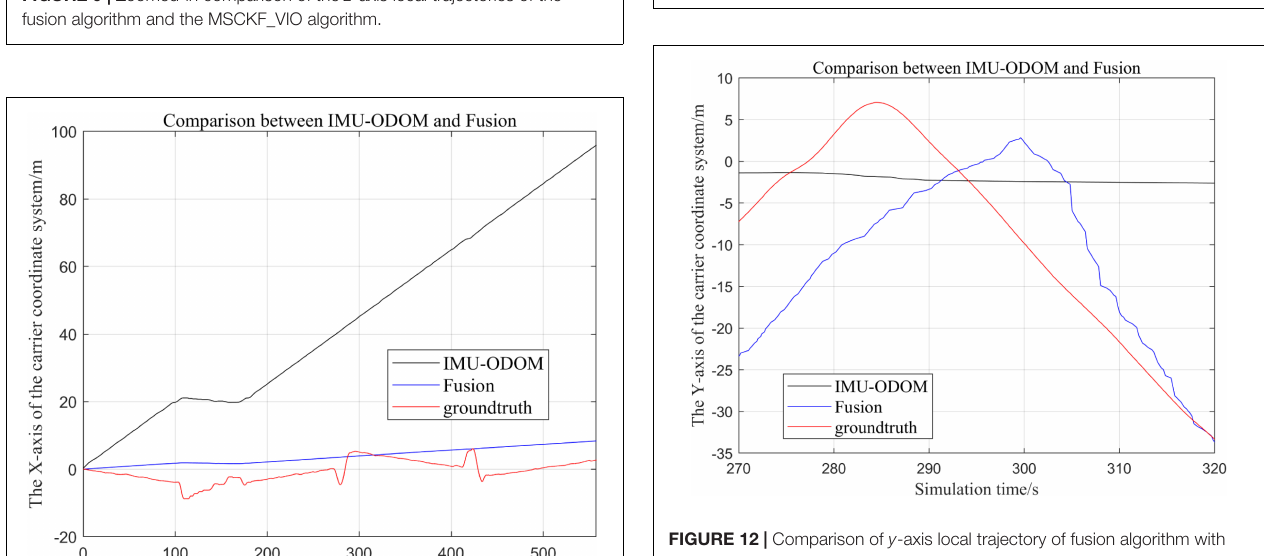
FIGURE 12 | Comparison of y -axis local trajectory of fusion algorithm with IMU and ODOM fusion